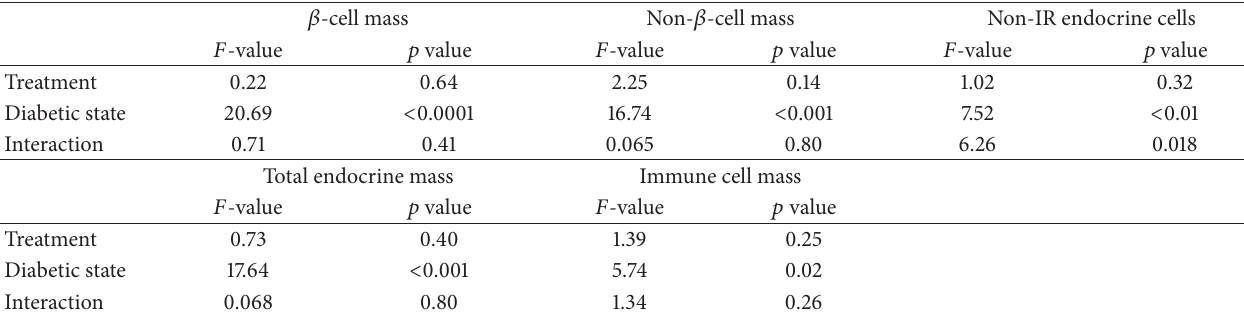
Table 2: The effect of diabetic state and compound administration.